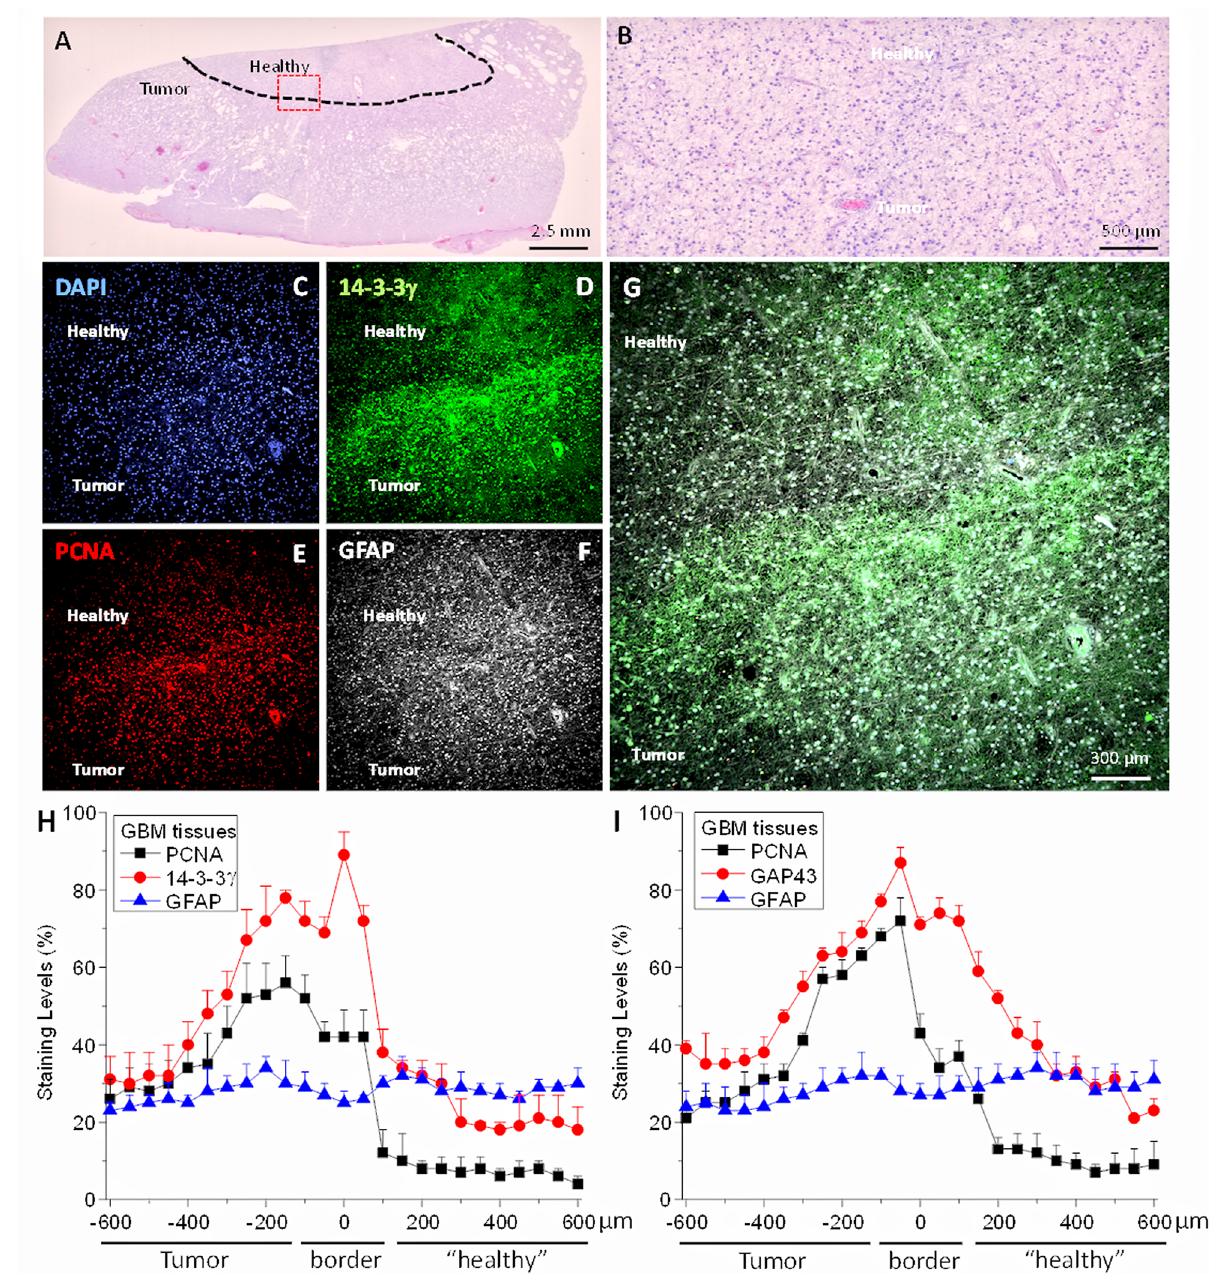
Figure 6. TNT are expressed in vivo at the interface tumor-healthy tissue. Primary GBM tumors were stained for H&E and immunofluorescence for DAPI (nuclear staining, blue staining), 14-3-3γ (TNT marker, green staining), PCNA (proliferation marker, red staining), GFAP (Glial marker, white staining), and merge colors. ( A ) Correspond to a large H&E of the tissue analyzed. ( B ) Amplification of the area denoted in red in the picture showed in A. The segmented line indicates the border of the tumor versus the healthy surrounding tissue. ( C – G ) Immune staining clearly indicates that protein 14-3-3γ (a TNT marker) is concentrated at the edge of the tumor, and most expression is from the tumor to the healthy surrounding areas ( D ). PCNA staining indicates preferential cellular proliferation in the tumor ( E ) and high glial activation at the tumor border as determined by GFAP staining ( F ). ( G ) Correspond to the merging of all the colors. ( H ) Correspond to the quantification of the fluorescence at different distances from the border or interface tumor-healthy tissue. Each point corresponds to the accumulated positive pixels every 40 µm into the tumor or healthy tissue for PCNA, 14-3-3-γ, and GFAP. ( I ) Correspond to the fluorescence quantification at different distances from the border or interface tumor-healthy tissue for PCNA, GAP43, and GFAP. In both graphs, the PCNA signal was significantly higher in the tumor (p = 0.0051 as compared to the healthy tissue. n = 4 different stage 4 GBM tumors from 4 different individuals). Proteins 14-3-3-γ and GAP43 were significantly concentrated at the tumor-healthy border, 400–300 µm (p = 0.00294 as compared to the healthy tissue. n = 4 different stage 4 GBM tumors from 4 different individuals). In contrast, GFAP in both graphs was high at the three areas analyzed, tumor, border, and healthy tissue (p = 0.143 as compared to the healthy tissue for all the points. n = 4 different stage 4 GBM tumors from 4 different